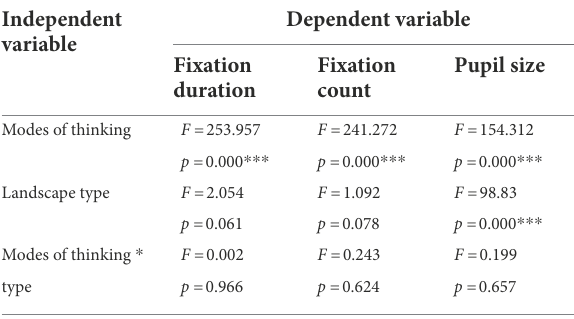
TABLE 3 Mixed-design analysis of variance.